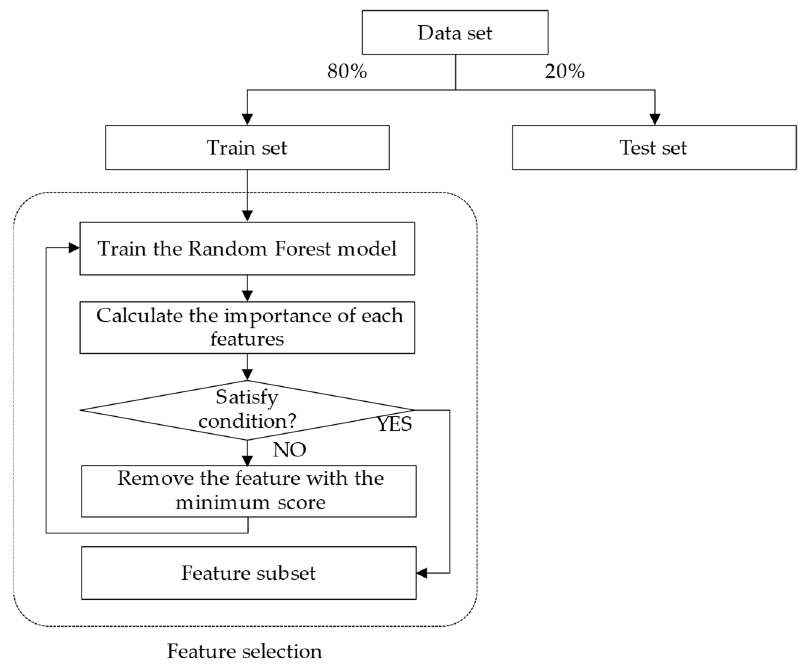
Figure 5. Flow chart of feature selection.